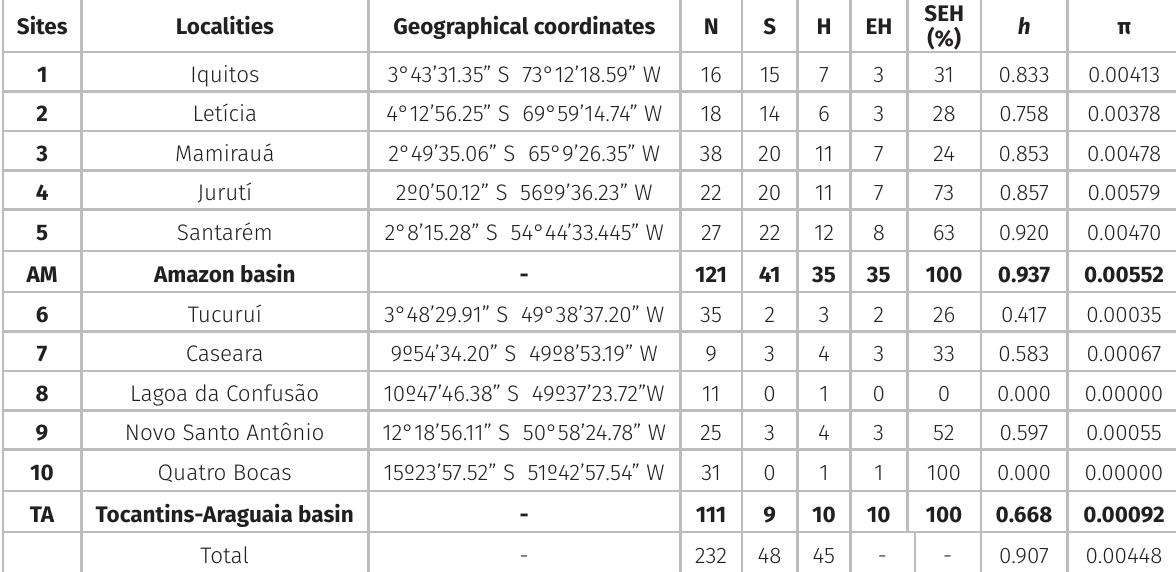
Table I. Genetic diversity indices for Arapaima based on an analysis of the concatenated ( Cytb and Control Region)